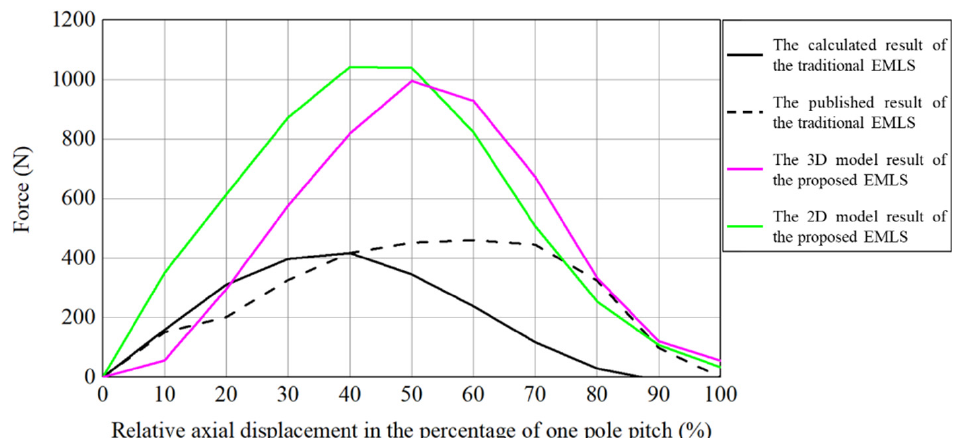
Figure 4. The thrust force curve of the FE models.